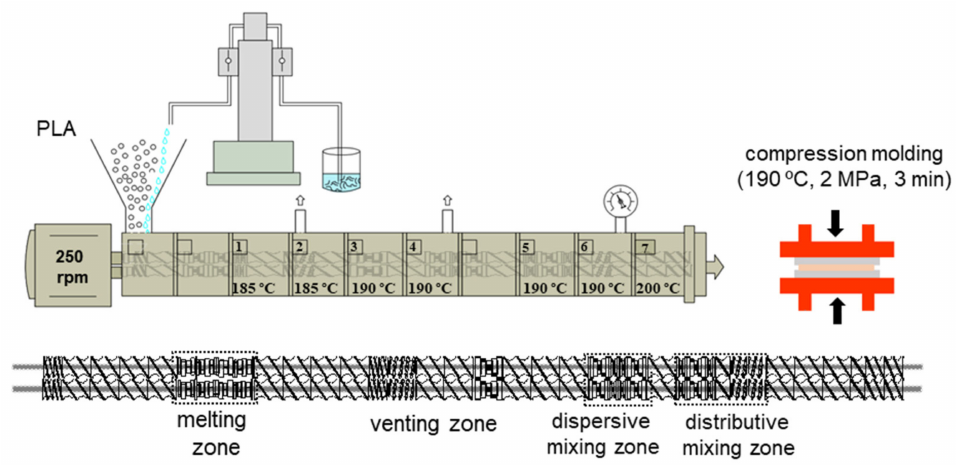
Figure 9. Schematic diagram of the liquid-assisted extrusion process displaying the process parame- ters and the twin-screw design showing different